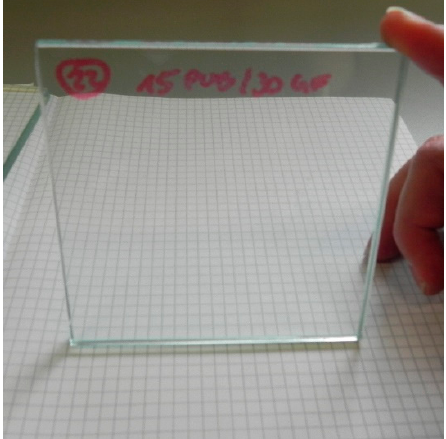
Figure 7. Sample after lamination with two additional glass panes for optical characterization.